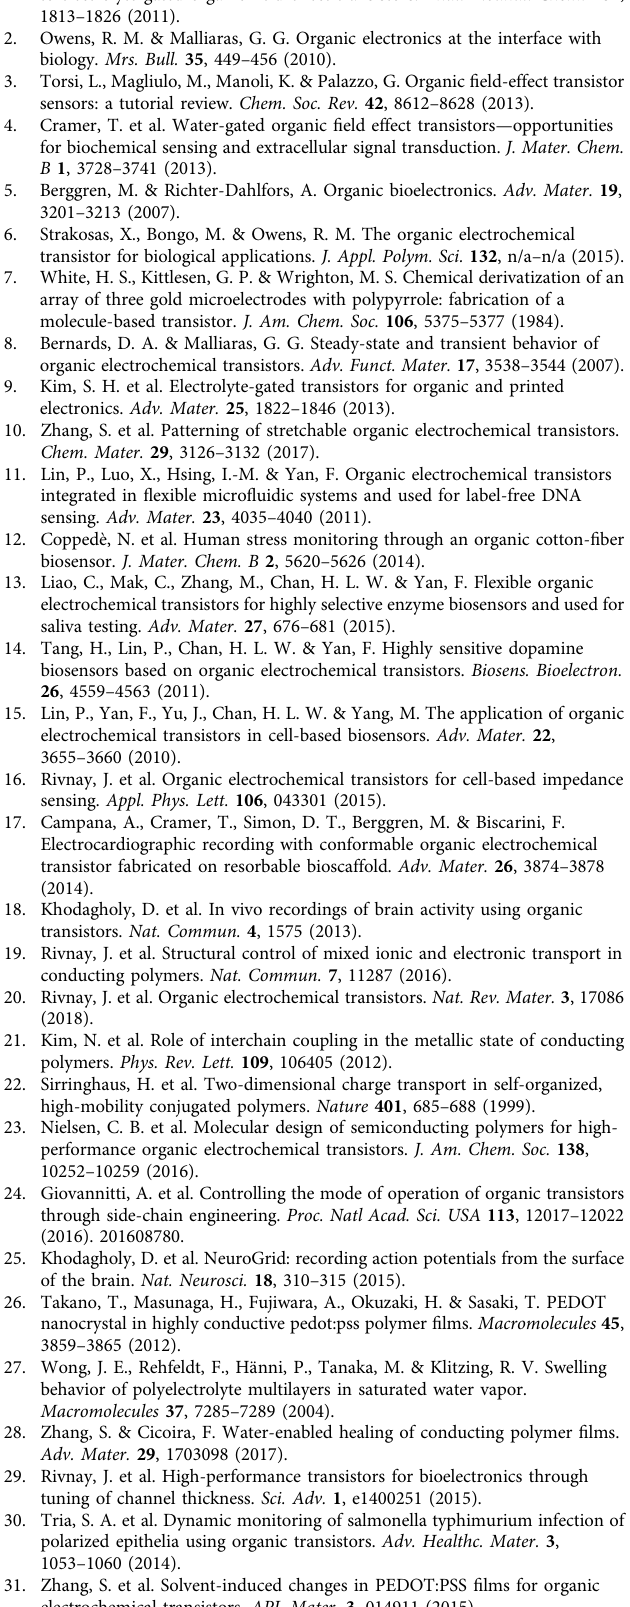
table bioelectronics targeted at chronic neural recording and